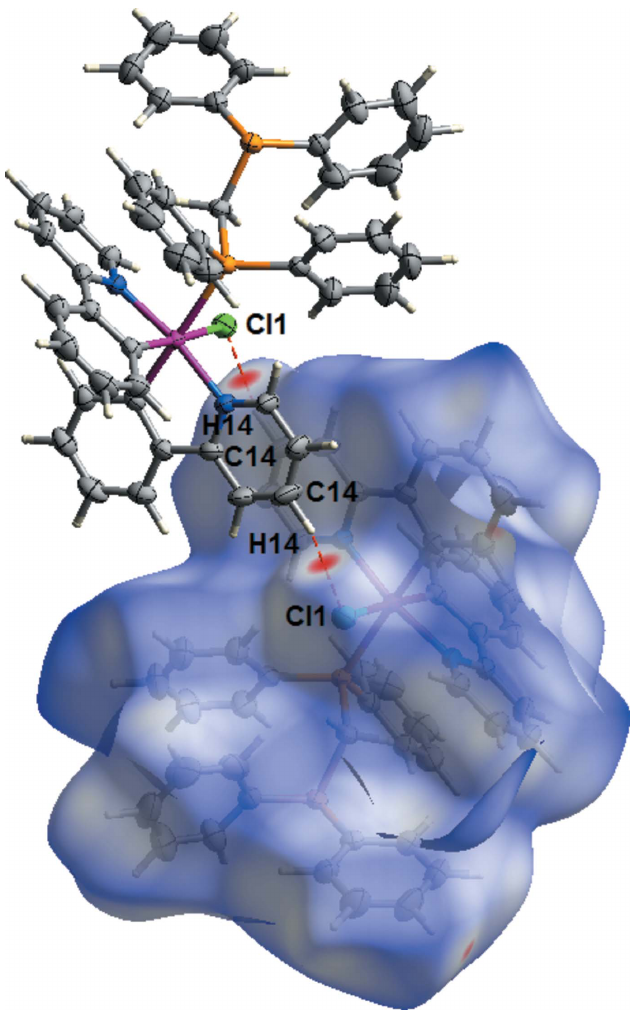
Figure 5 Hirshfeld surface plot showing the C—H (cid:3)(cid:3)(cid:3)(cid:3) Cl